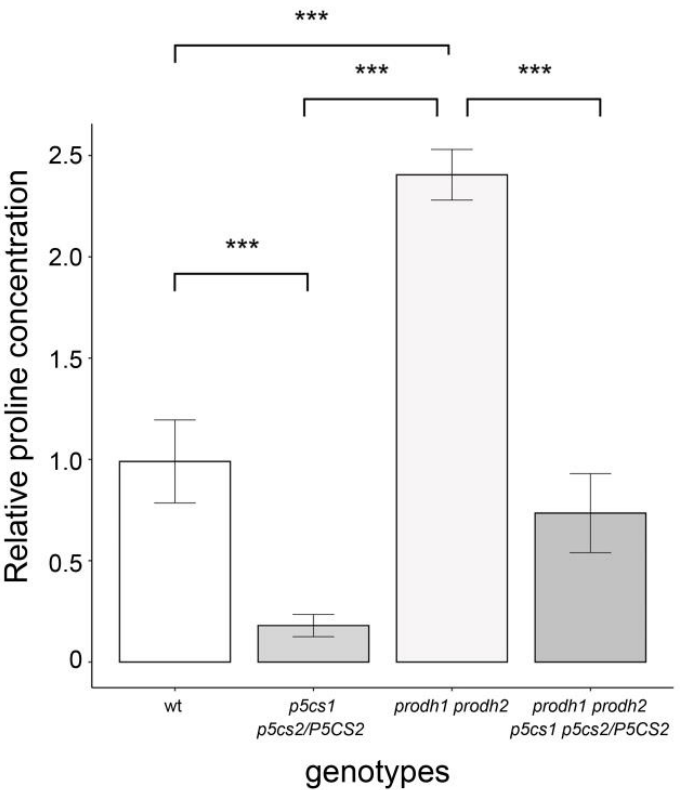
Figure 8. Endogenous proline levels in plantlets from different proline metabolism mutants. Intracellular levels of proline were extracted from 0.5 g (FW) of either wildtype, p5cs1 p5cs2/P5CS2 , prodh1 prodh2 , or prodh1 prodh2 p5cs1 p5cs2/P5CS2 plantlets with 5-sulphosalycidic acid and measured with the Bates assay [37]. The average proline concentrations were derived from three independent experiments, each one with ten samples and three technical replicates. The differences in proline content among genotypes were analyzed with the non-parametric Kruskal–Wallis test, followed by a pairwise Wilcox test which found significant (*** p < 0.001) differences among genotypes except for wildtype vs. p5cs1 p5cs2/P5CS2 , prodh1 prodh2. The proline concentrations were normalized to wildtype